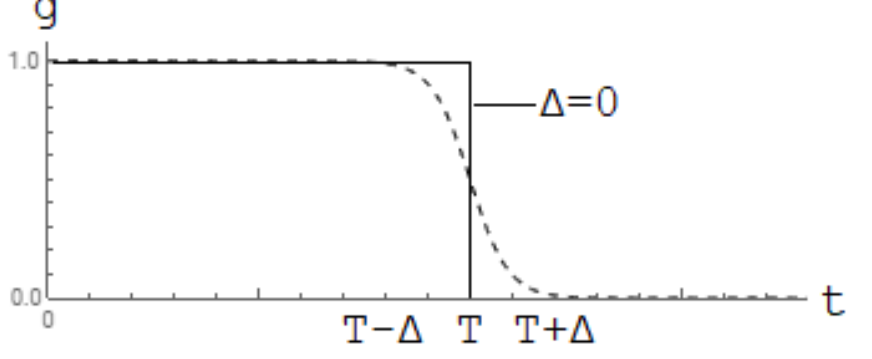
Figure 6. Virus lifetime function. Dashed line approximates the lifetime function by Fermi dependence 𝒈(𝒕) = (𝟏 + −𝟏 and solid line corresponds to the step-like limiting case 𝒆 (𝒕−𝑻)/∆ ) 𝜽(𝑻 −